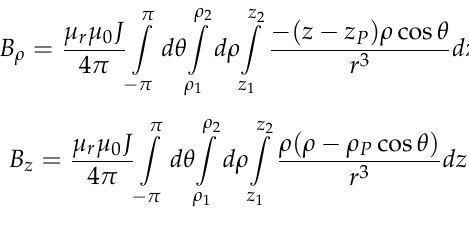
Figure 3. Model for computing the field strength.